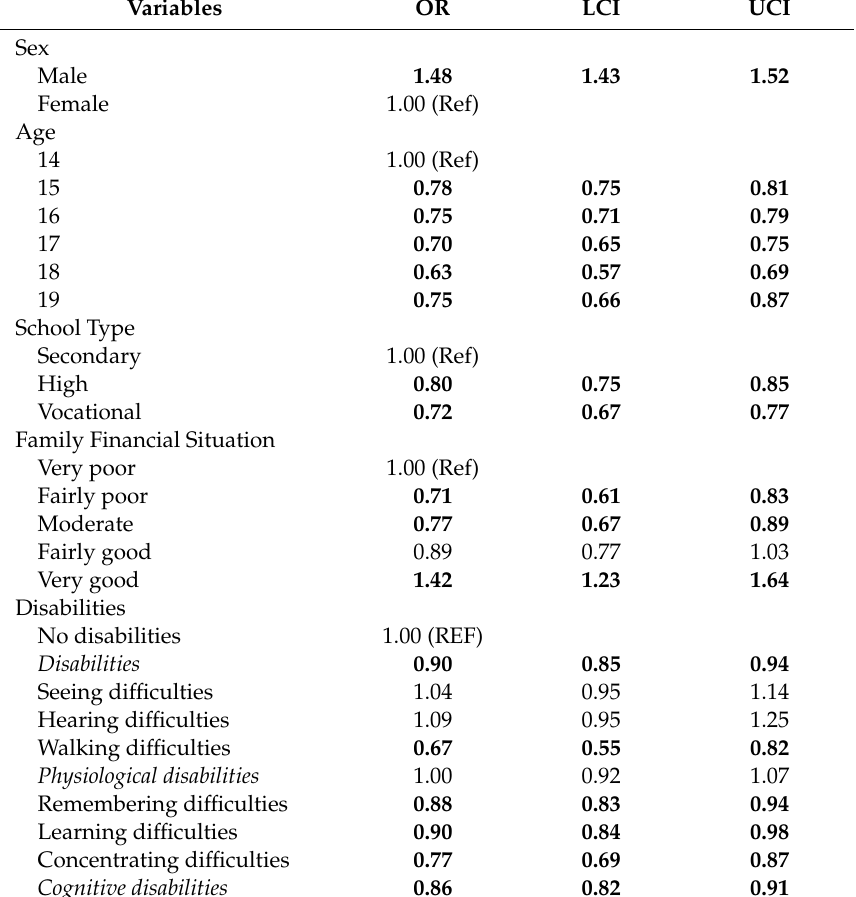
Table 2. Adjusted binary logistic regressions for meeting physical activity